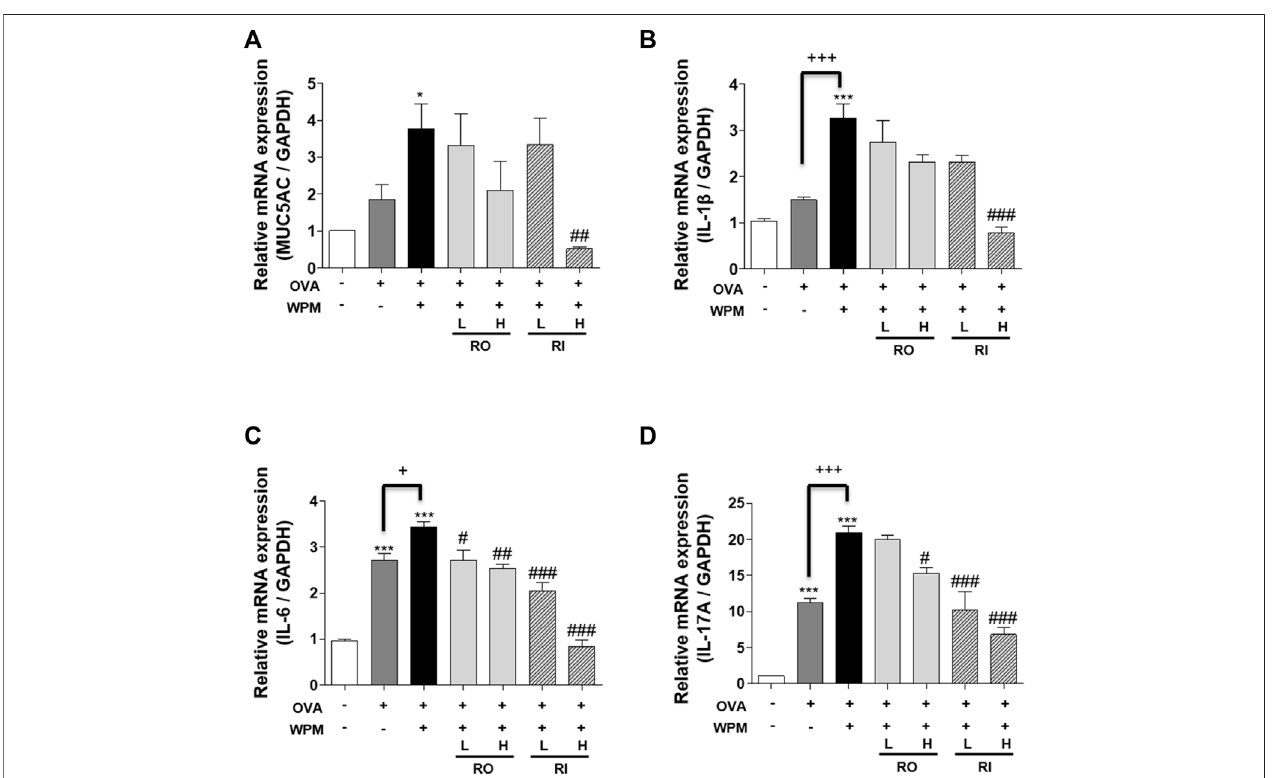
FIGURE 6 | The effects of RL on the mRNA level of MUC5AC and pro-in fl ammatory cytokines in the lungs of WPM-exacerbated mouse model of asthma. (A) The mRNA levels of MUC5AC, and (B – D) in fl ammatory cytokines, (B) IL-1 β , (C) IL-6 and (D) IL-17A were analyzed by real-time PCR. All data are presented as the mean ± SEM. n = 5/group. * p < 0.05 and *** p < 0.001 compared with the control group; # p < 0.05, ## p < 0.005 and ### p < 0.001 compared with the OVA + WPM group; + p < 0.05 and +++ p < 0.001 compared with the OVA group.